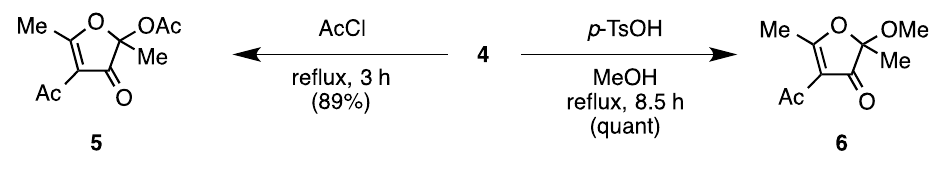
Table 1. Reaction of Mn(acac) 3 1 and 2,4-Pentanedione (Hacac) with Mn(OAc) 3 in AcOH 2 .